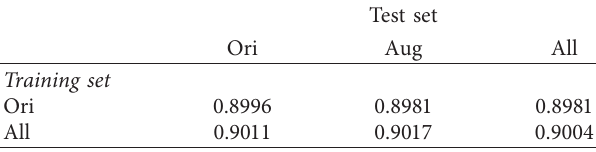
Table 3: Test results before and after random translation.